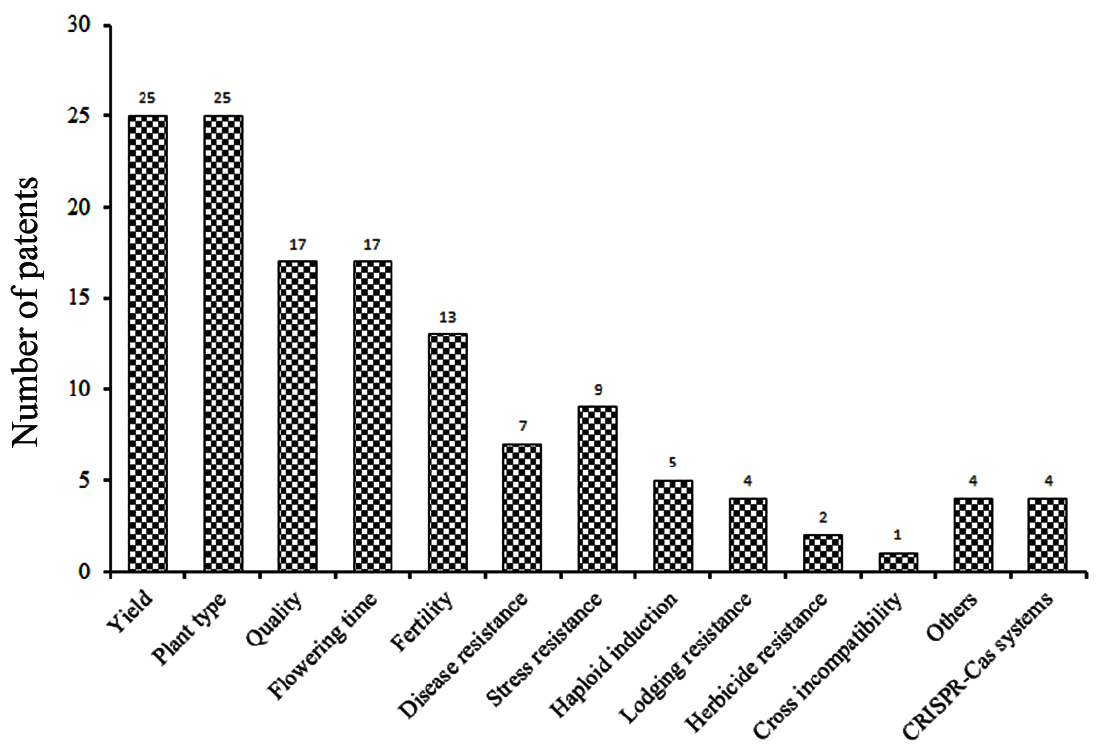
Figure 2. The number of patents related to the improvement of maize traits using CRISPR-Cas tech- nology.